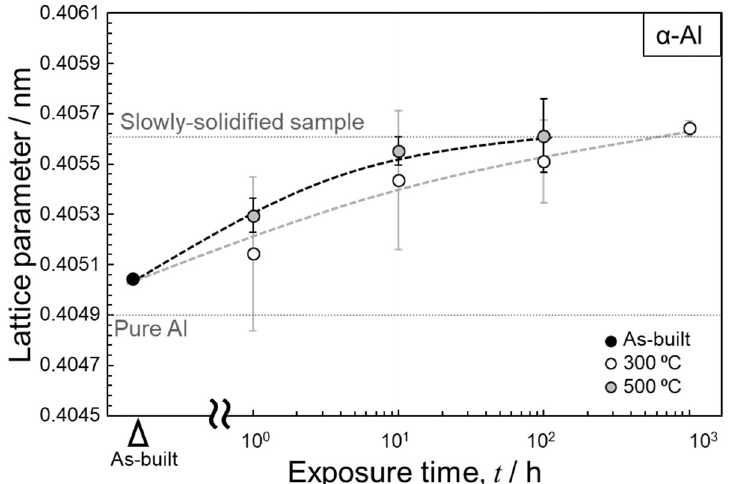
Figure 9. Changes in lattice parameter of the L-PBF-built Al–15%Fe alloy samples as a function of exposure